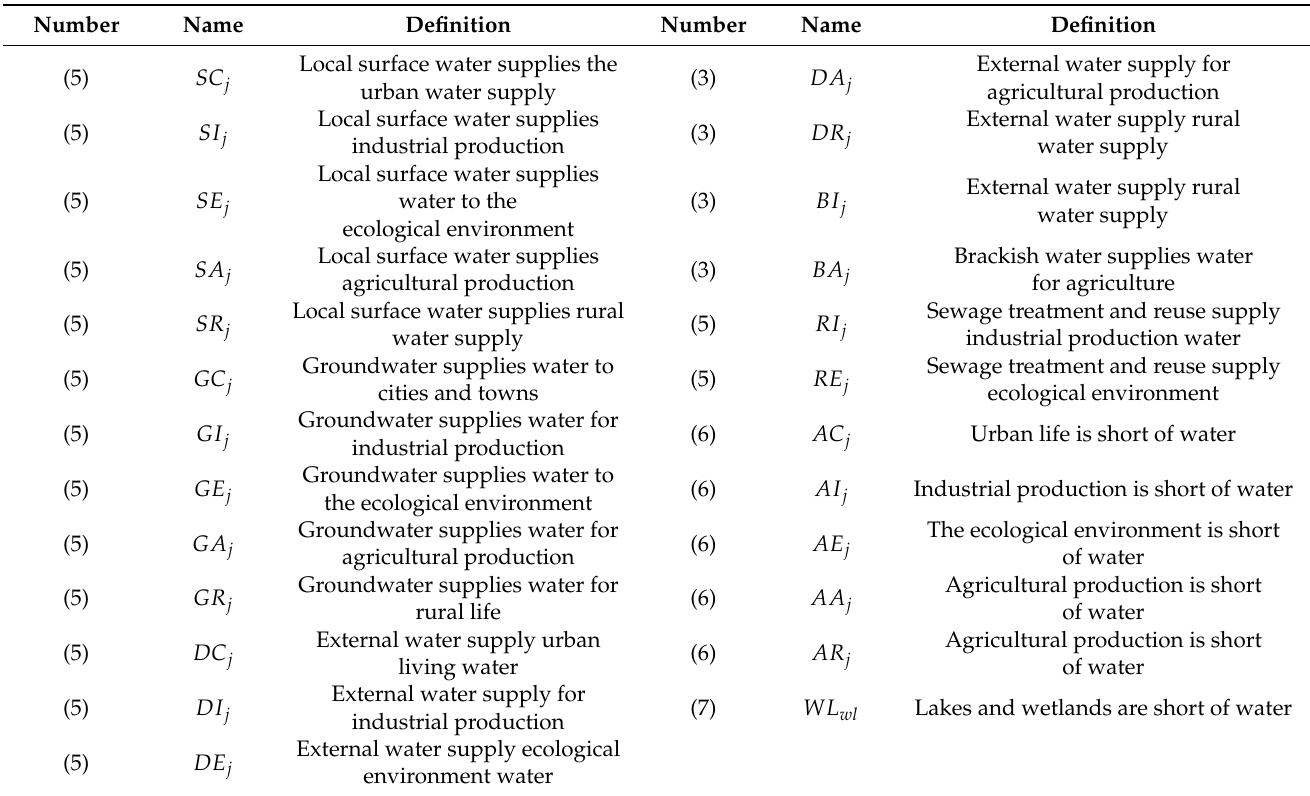
Table 1. Variable